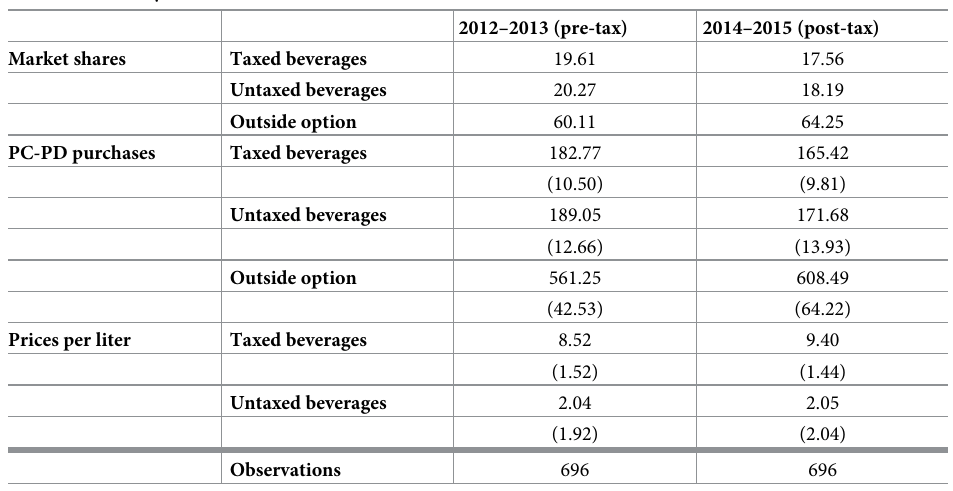
Table 1. Summary statistics.